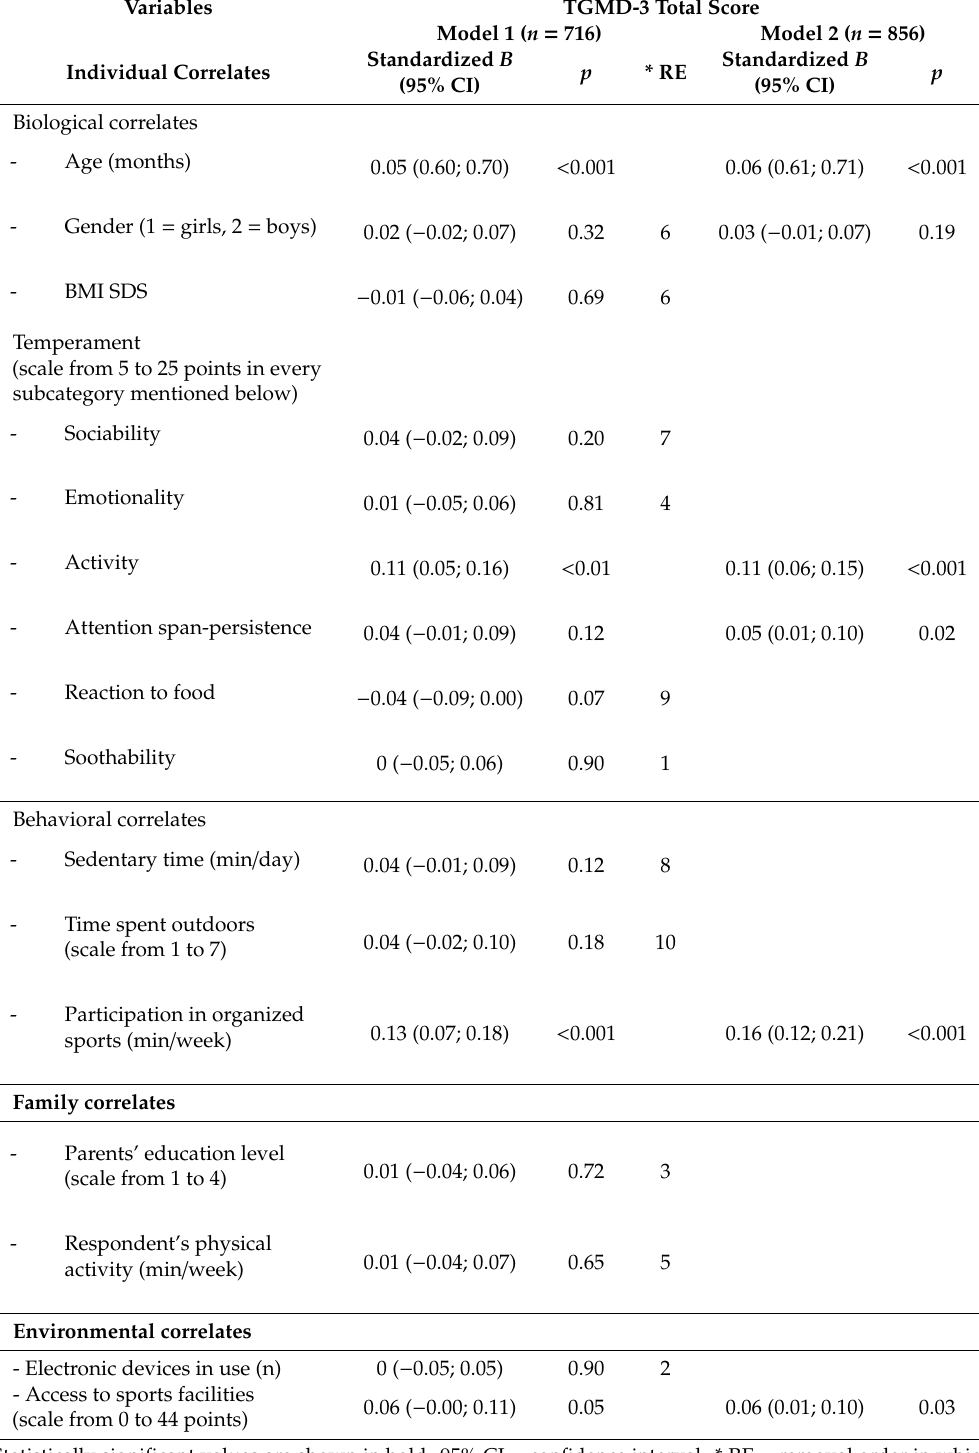
Table 2. Individual, family and environmental correlates associated with children’s TGMD-3 total